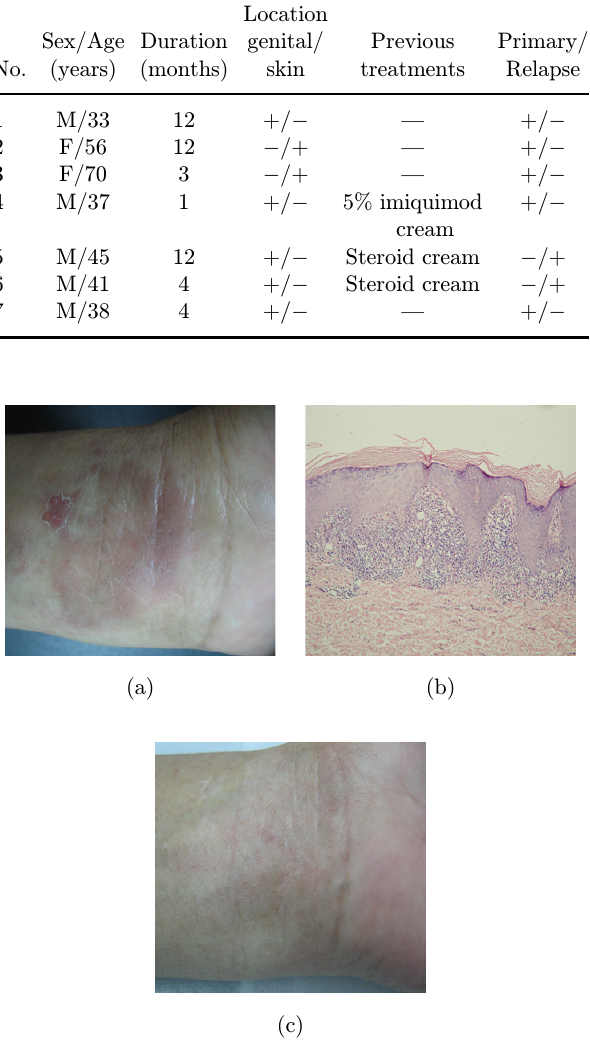
Fig. 1. LP located on the wrist (Case 2). (a) gross view before PDT, (b) histopathological view before PDT ( (cid:2) 400) and (c) CR at six months after four courses of PDT treatments.